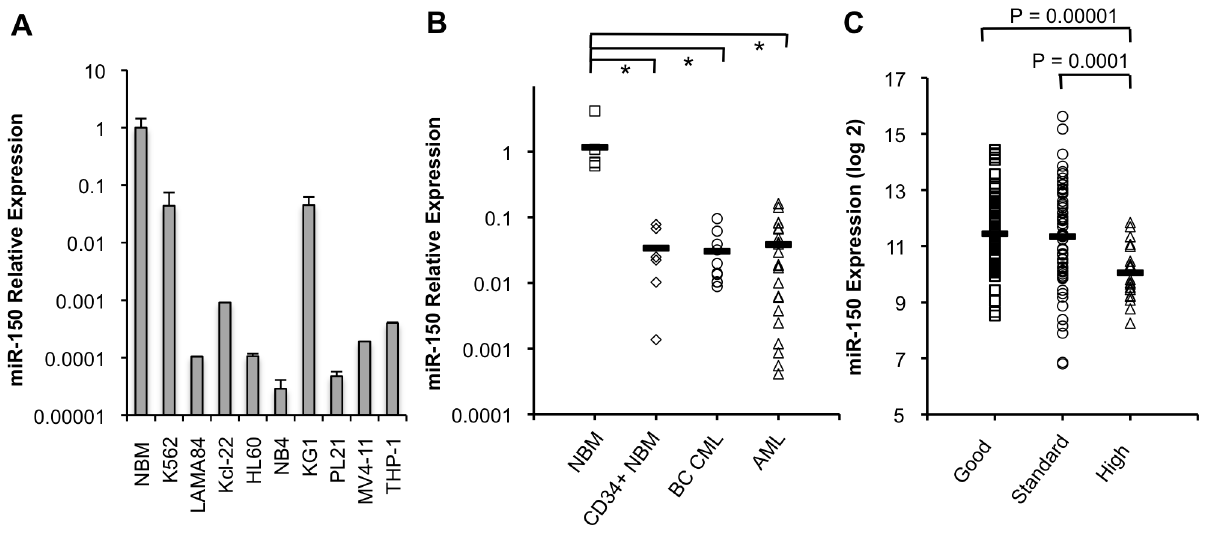
Figure 1. Mature miR-150 expression is low in myeloid leukemia cells. Mature miR-150 expression is decreased in CML and AML cell lines and in primary patient CD34+ progenitor cells from healthy individuals, BC CML and AML samples relative to average miR-150 expression in normal bone marrow (NBM). (A) MiR-150 expression is low or absent in BC CML (K562, LAMA84, and Kcl-22) and AML (HL60, NB4, KG1, PL21, MV4-11, and THP-1) cell lines. Expression is shown as a fold-change relative to miR-150 expression in NBM on a log scale as determined by QPCR (performed in duplicate). (B) By QPCR, miR-150 expression was 10 decreased in CD34+ sorted (n=6) vs. unsorted (n=5) NBM. In primary BC CML (n=10) and adult AML (n=22) patient samples, miR-150 expression was significantly decreased compared to unsorted NBM, but not sorted CD34+ NBM. Individual patient samples are shown as fold-change relative to miR-150 expression in NBM on a log scale, with means indicated by bars (* P≤0 . 05, 10 **P≤0.001 for comparisons, Student’s t-test). (C) MiR-150 expression was obtained by RNA sequencing for 182 pediatric AML cases and was stratified by risk group based on cytogenetic and molecular abnormalities. Expression is on a log scale, with 2 averages indicated by bars (Student’s t-test used for